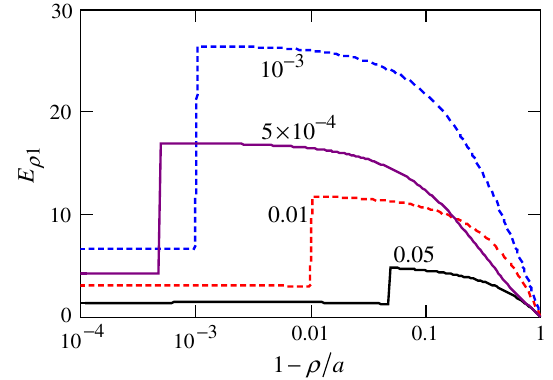
FIG. 4. Dependency of the radial electric field amplitude ð KV = m Þ of the first mode on the distance from the wave- E (cid:6) 1 guide boundary for a ¼ 5 mm , " ¼ 4 , j q j ¼ 1 pC , (cid:4) ¼ 0 , and (cid:1) ¼ 30 ; the magnitudes of d=a are given near the curves.